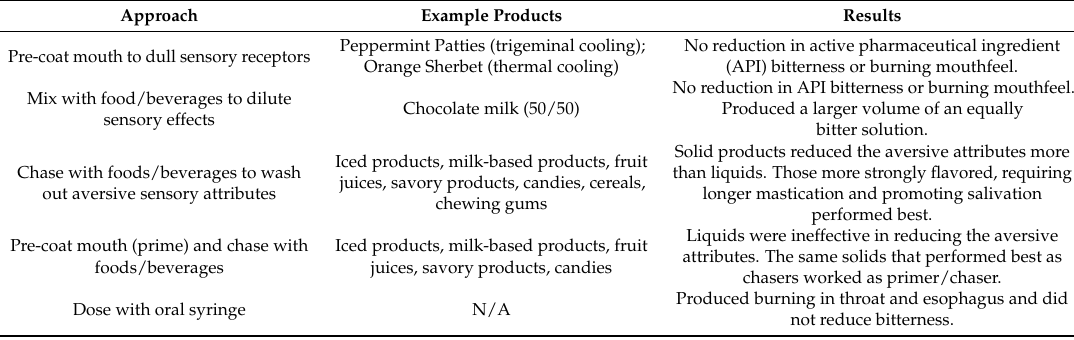
Table 1. Results of approaches to ameliorate the flavor impact of Norvir ® 80 mg/mL oral solution.